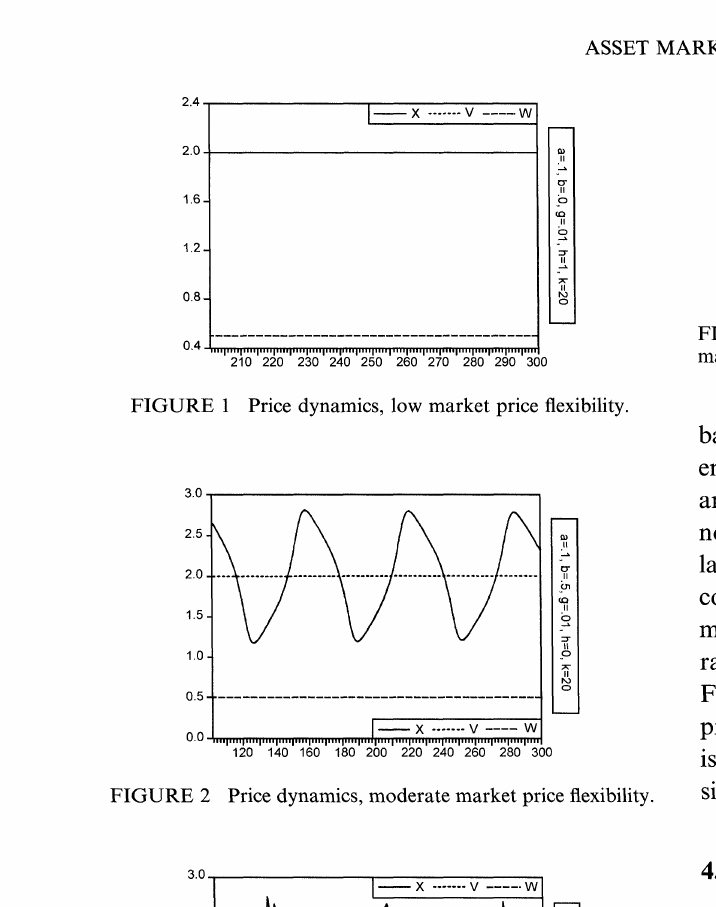
FIGURE 4b Distribution of price change rates, very high market price flexibility.